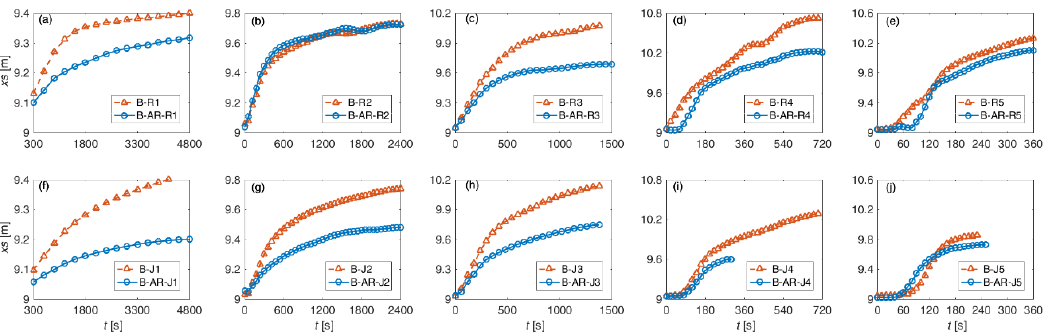
Figure 14. The variation of the scarp position ( xs ) over time duration ( t ) (upper panels ( a )–( e ) show the comparison between B and B-AR tests under regular wave conditions, and lower panels ( f )–( j ) show the comparison under irregular wave conditions)